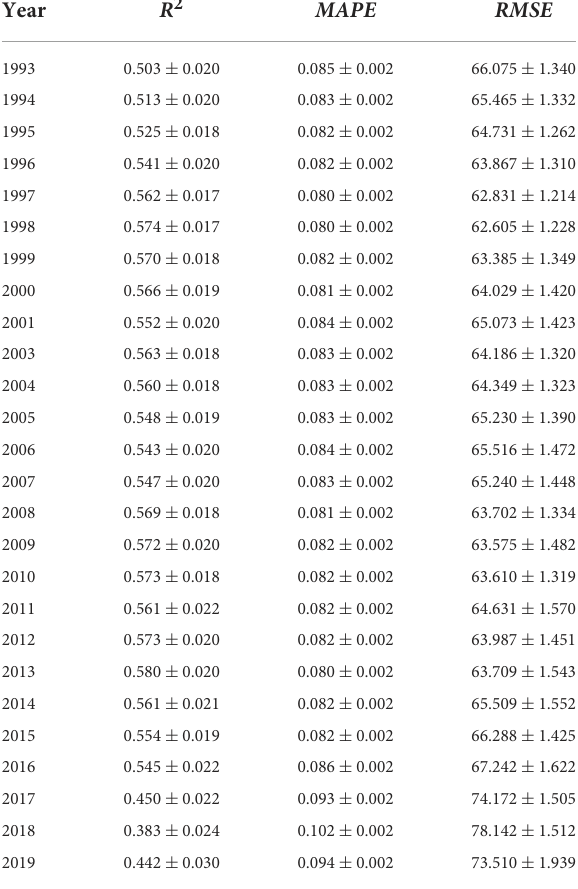
TABLE 1 Summary table of performance measures obtained for each year.